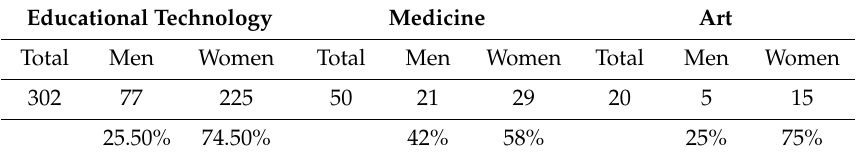
Table 1. Number of participants in each one of the experiments.